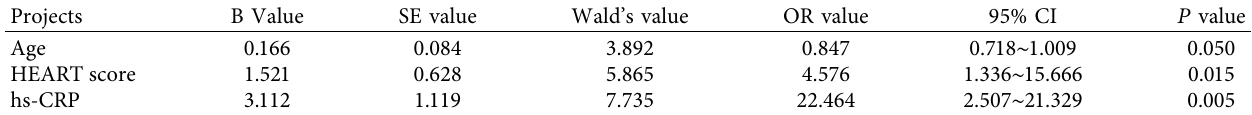
Table 4: Risk factors for 30d MACE in patients with acute chest pain.